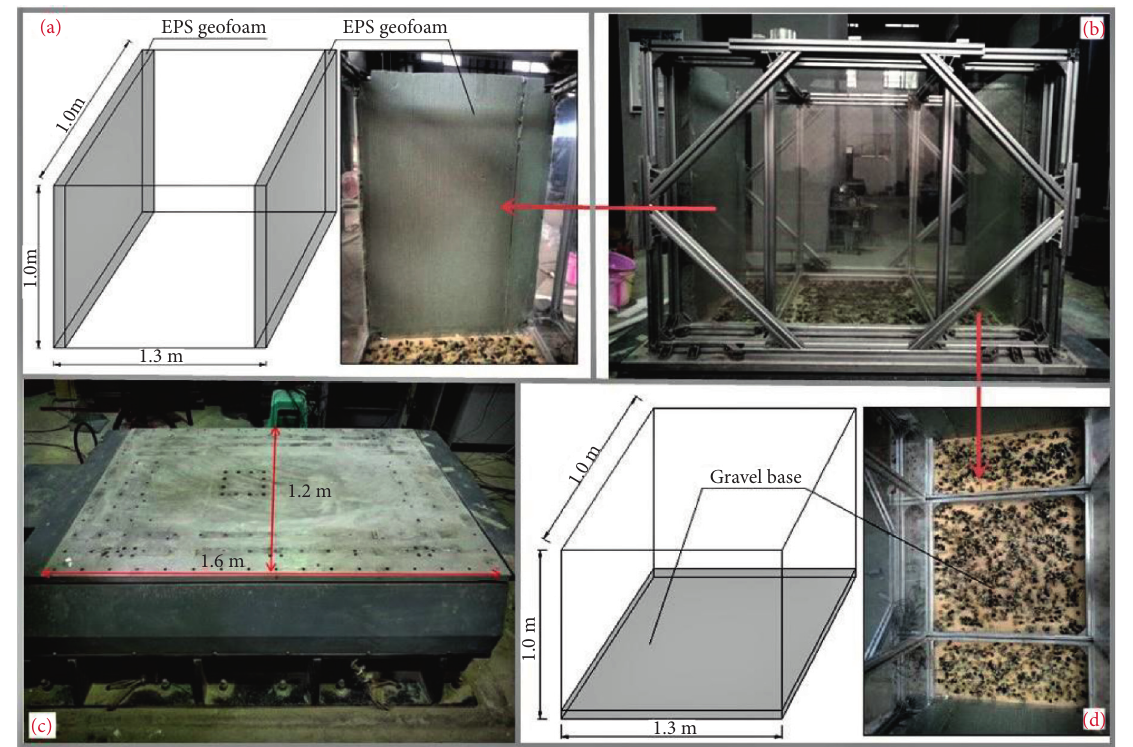
Figure 3: Model test device. (a) Polystyrene foam board. (b) Model box. (c) Shaking table. (d) Grave Table 2: Main parameters of the shaking table.